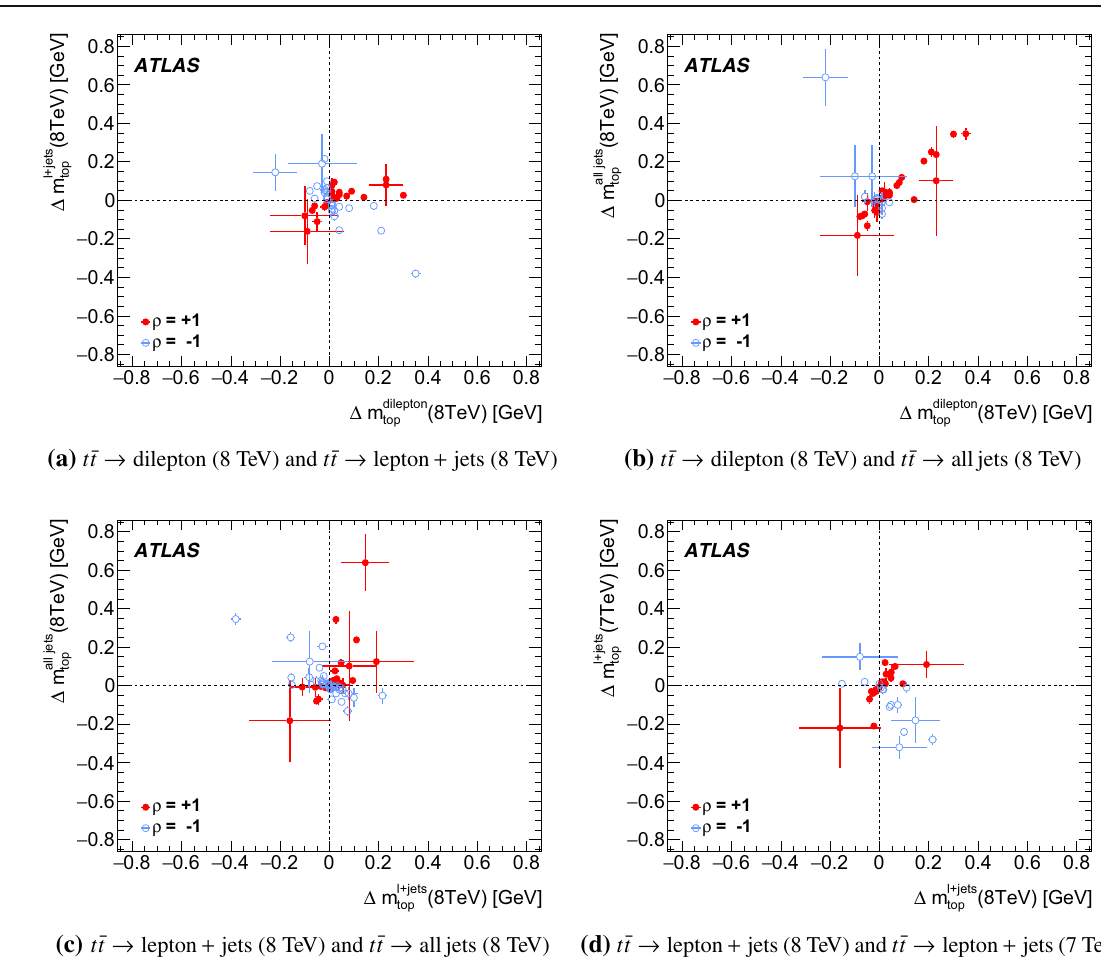
√ s = 8 TeV, measurement with the t ¯ t → alljets measurement at while d shows the correlations of the present measurement with the √ t ¯ t → lepton + jets measurement at s = 7 TeV. The crosses indi- cate the statistical uncertainty in the systematic uncertainties. The solid points indicate the fully correlated cases, and the open points indicate the anti-correlated ones